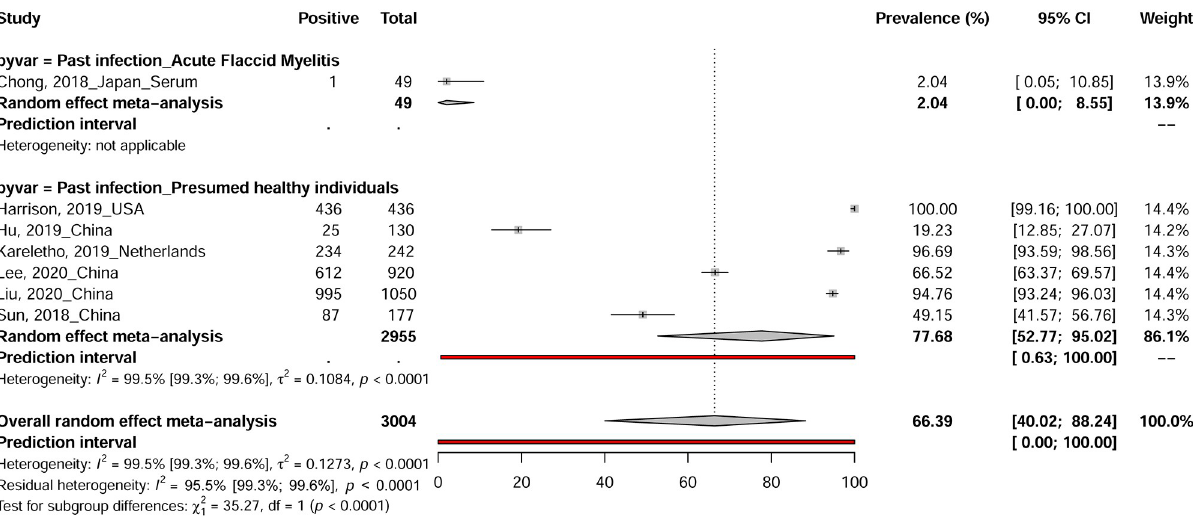
Egger’s test indicates that no publication bias was observed for the estimates of CFR and preva-